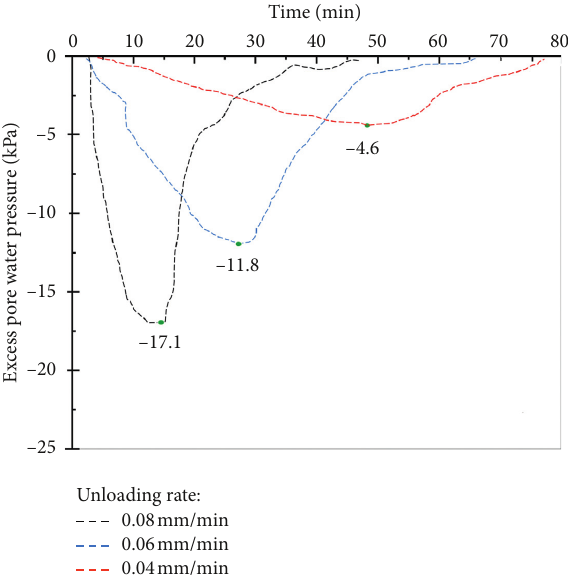
Figure 8: Curves of excess pore water pressure values with time under different unloading rates at a confining pressure of 63kPa.